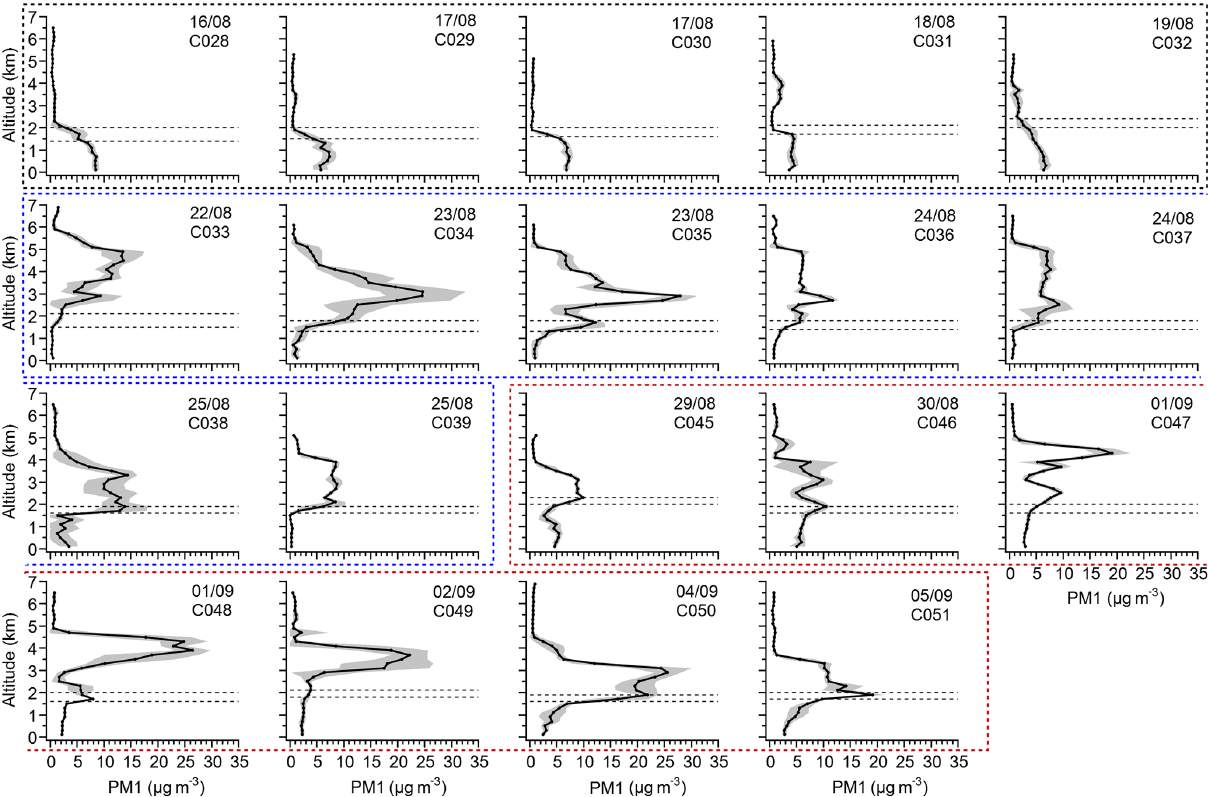
Figure 2. The average vertical distribution of submicron aerosol (PM 1 ) in flights used in this study. The mass concentration of PM 1 is cal- culated from AMS non-refractory submicron species and SP2 BC. The grey shades represent standard deviation. The dashed lines represent the low and upper level of the inversion layer. Period 1 is marked by the black dashed rectangle, which shows that BBA was concentrated in the BL. Period 2 is marked by blue, which shows that the FT was BB-polluted and the BL was mostly clean. Period 3 is marked by red, which shows that the BB pollution was observed throughout the BL and FT. Table 1. The summary of CLARIFY aerosol composition and comparison with other studies of southern African